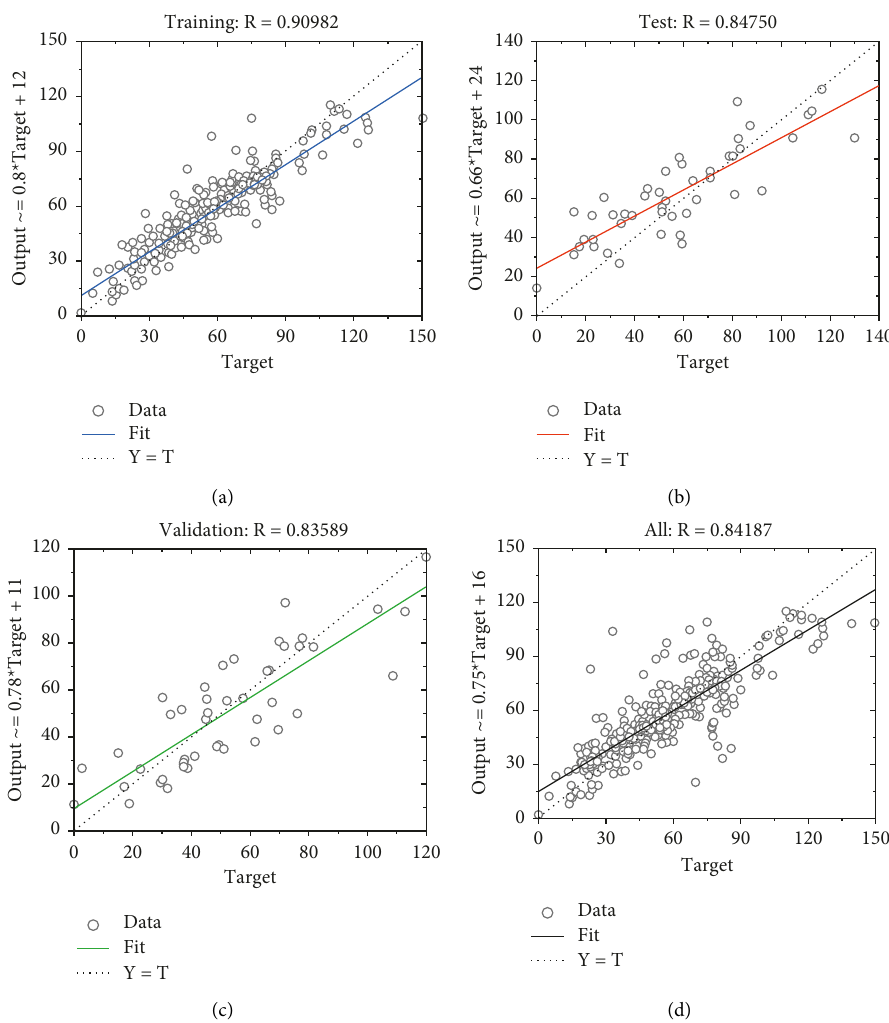
Figure 3: Regression of ANN modeling for prediction of 28d compressive strength of AAS. (a) Training. (b) Testing. (c) Validation. (d) All.